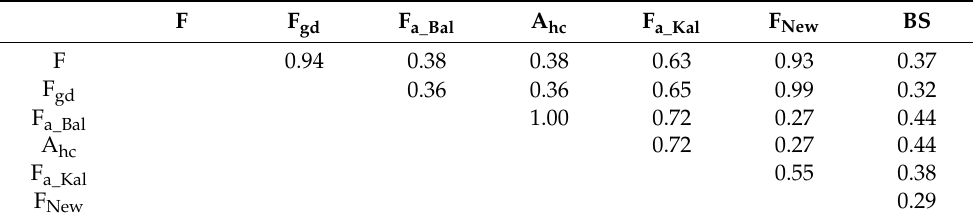
Table 4. Correlations between inbreeding coefficients according to Meuwissen (F), individual in- breeding using the gene drop method (F gd ), ancestral inbreeding according to Ballou (F a_Bal ) and Kalinowski (F a_Kal ), new inbreeding according to Kalinowski (F New ) and ancestral history coefficient according to Baumung (A hc ) and the breed proportions of US Brown Swiss (BS) for German Brown born between 1990 and 2014. All correlation coefficients showed p -values <